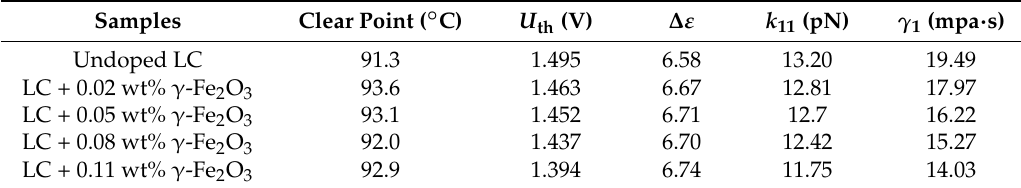
Figure 1. Optical path diagram of dynamic response.